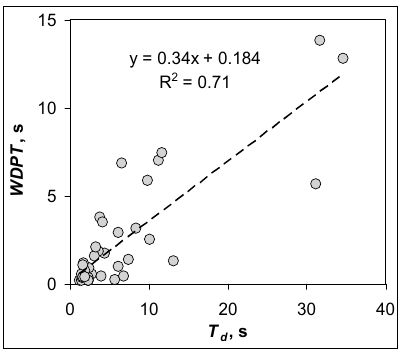
Figure 8. Correlation between water drop penetration time and time of aggregate destruction.